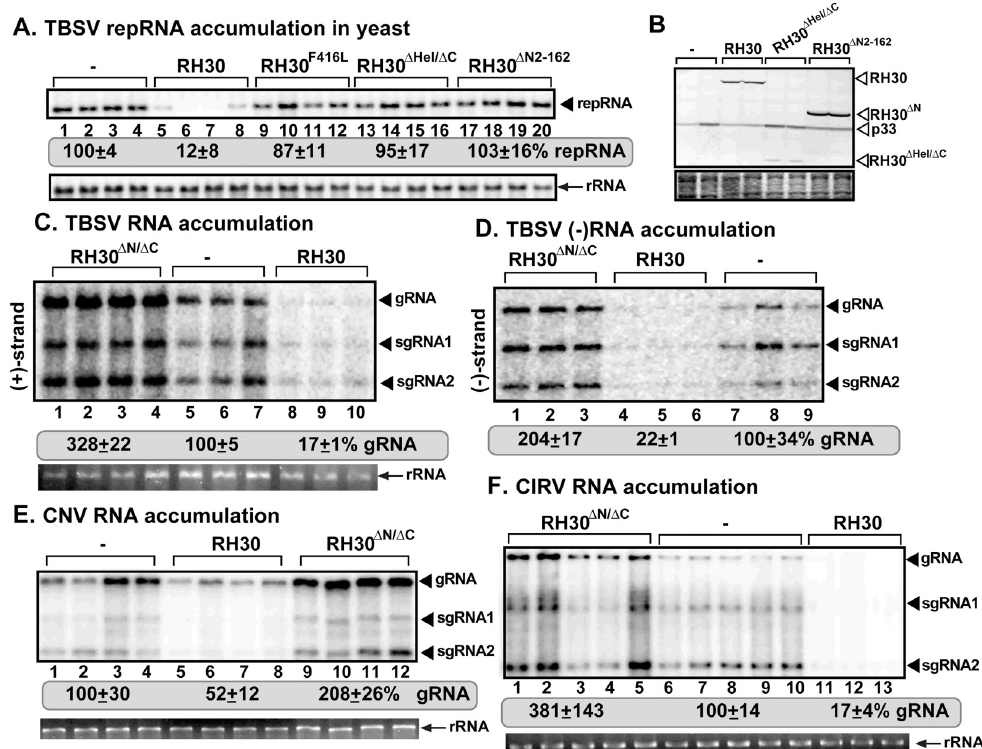
Fig 1. Effects of expression of truncation mutants of the antiviral RH30 DEAD-box helicase on tombusvirus genomic (g)RNA replication in N . benthamiana plant and in yeast surrogate host. (A) The effect of expression of truncation mutants of RH30 on TBSV replication in yeast. Top panel: Northern blot analysis of TBSV repRNA using a 3’ end specific probe shows the level of accumulation of repRNA in wt yeast strain expressing truncation mutants of RH30. Viral proteins His 6 -p33 and His 6 -p92 pol were expressed from plasmids from the CUP1 promoter, while DI-72(+) repRNA was expressed from the GAL1 promoter. His 6 -RH30 derivatives were expressed from a plasmid. Northern blots were evaluated with a phosphoimager using Imagequant software. Standard error was calculated based on three repeats. Bottom panel: Northern blot with 18S ribosomal RNA specific probe was used as a loading control. (B) Western blot analysis of the level of His 6 - p33, and His 6 -RH30 with anti-His antibody. The samples were from wt yeast strain expressing RH30 derivatives. (C) N . benthamiana plants expressing RH30 Δ N/ Δ C helicase were inoculated with (C-D) TBSV, (E) CNV, (F) CIRV, respectively. Top panel: Northern blot analyses of tombusvirus gRNA using a 3’ end specific probe shows increased accumulation of gRNA and subgenomic RNAs in plants expressing RH30 Δ N/ Δ C helicase when compared with plants expressing RH30 or in control plants (treatment with the empty vector). Bottom panel: Ethidium-bromide stained gel shows 18S ribosomal RNA as a loading control. Note that the northern blot analyses of TBSV (+)gRNA is shown in panel C and (-)gRNA using a 3’ end specific probe for (-)RNA detection is shown in panel D. Each experiment was repeated at least three times.